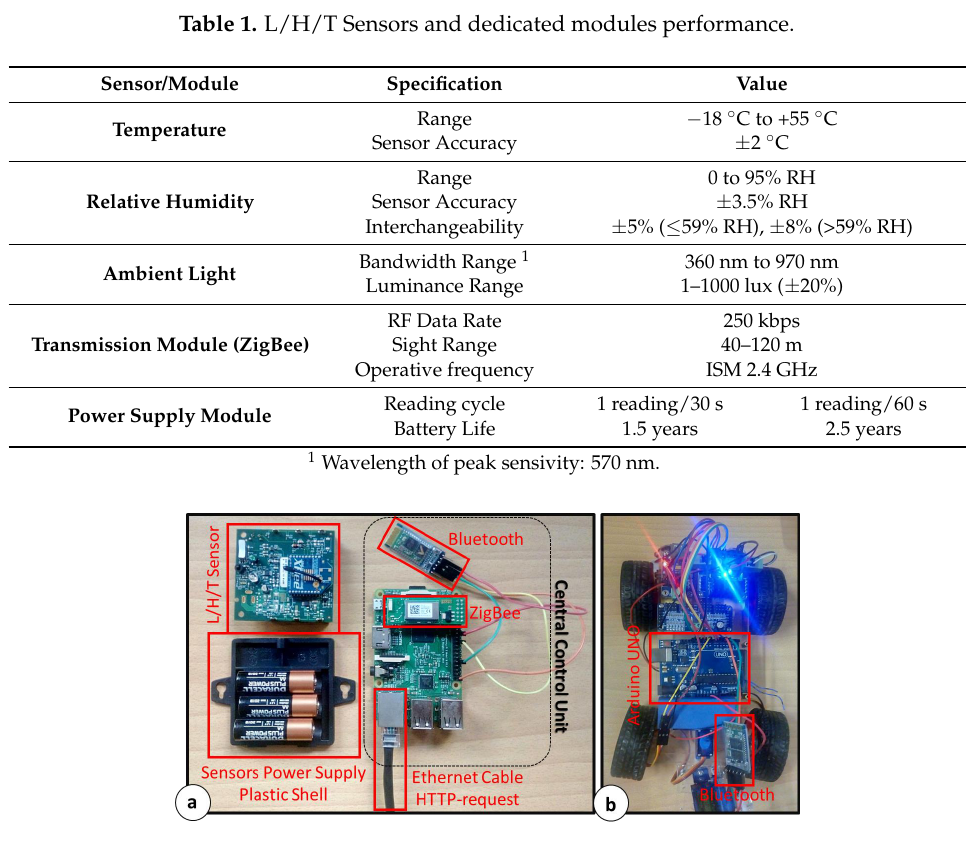
Figure 2. Architecture components: ( a ) L/H/T sensor and Raspberry Pi 2 Model B+ equipped with ZigBee and Bluetooth modules ( b ) prototype car driven by Arduino UNO core and Bluetooth.